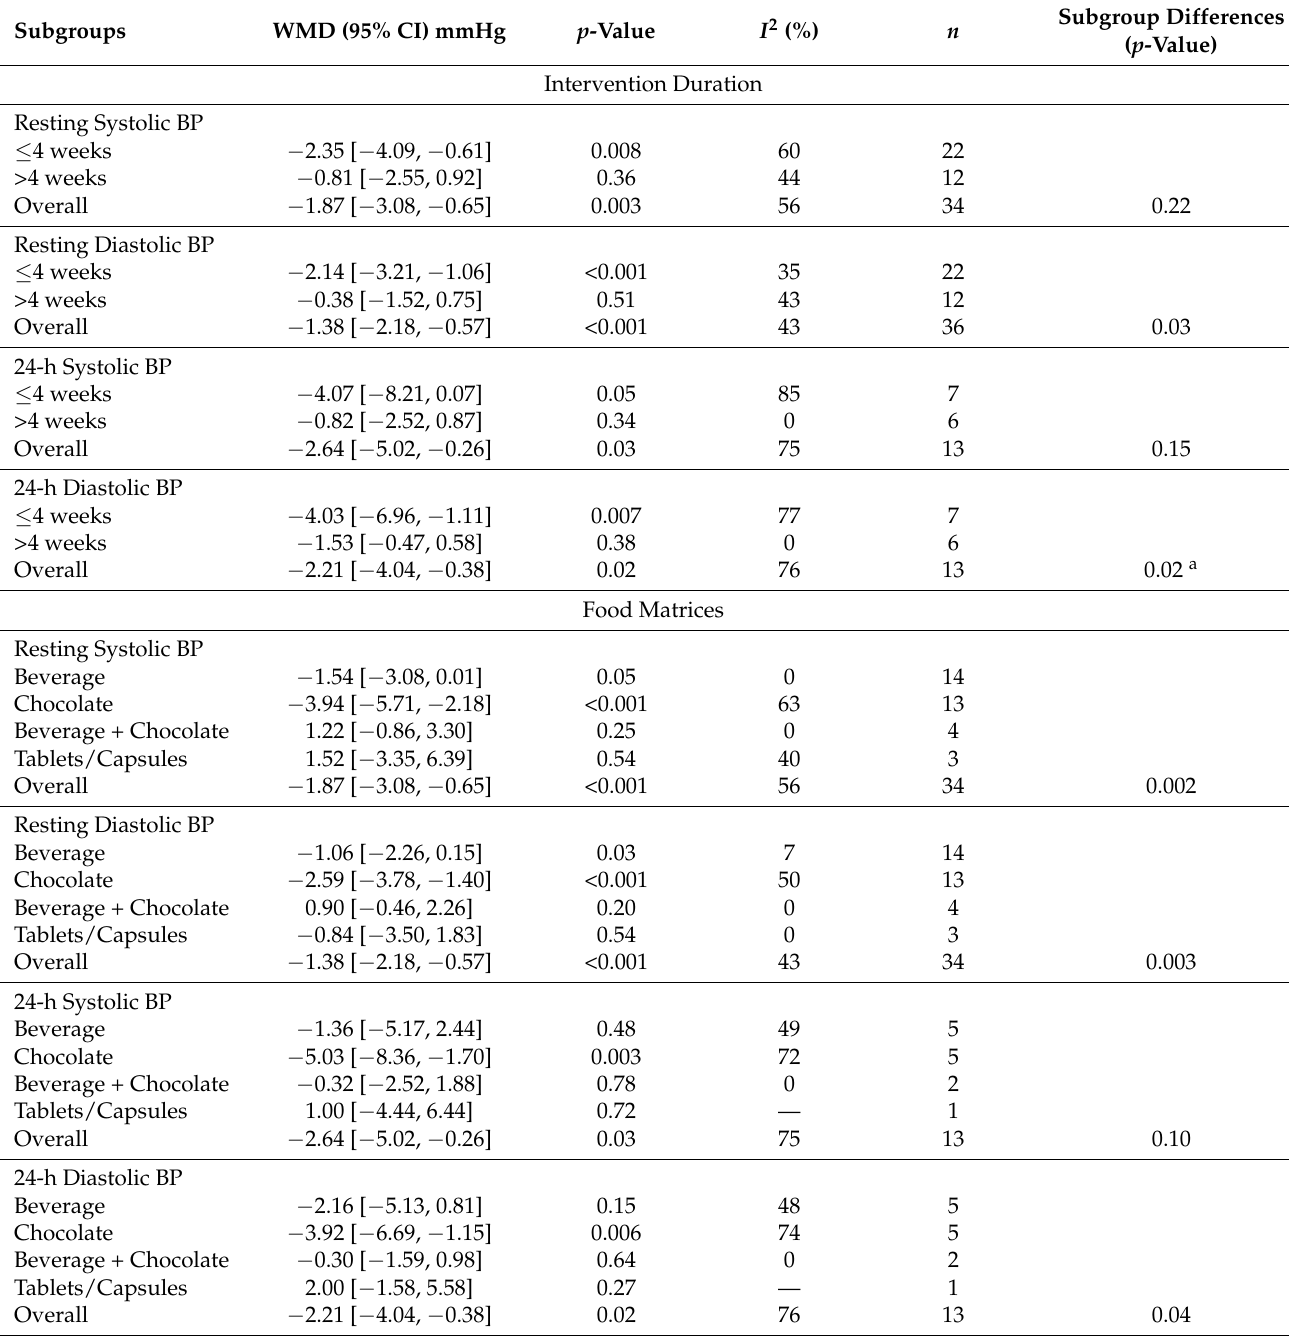
Table 2. Summary of subgroup